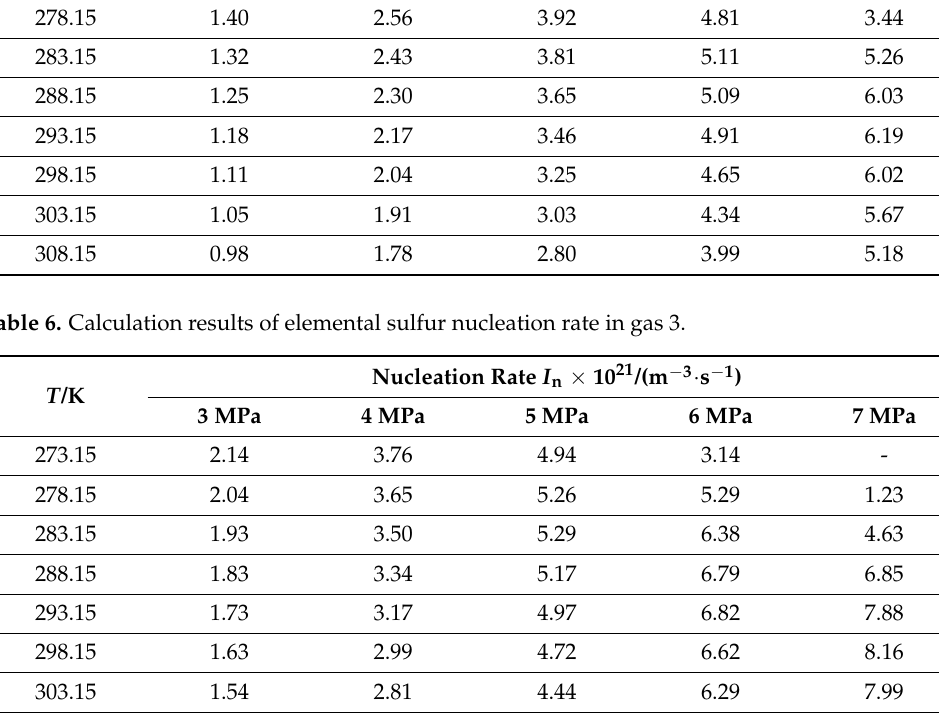
Table 5. Calculation results of elemental sulfur nucleation rate in gas 2. T /K